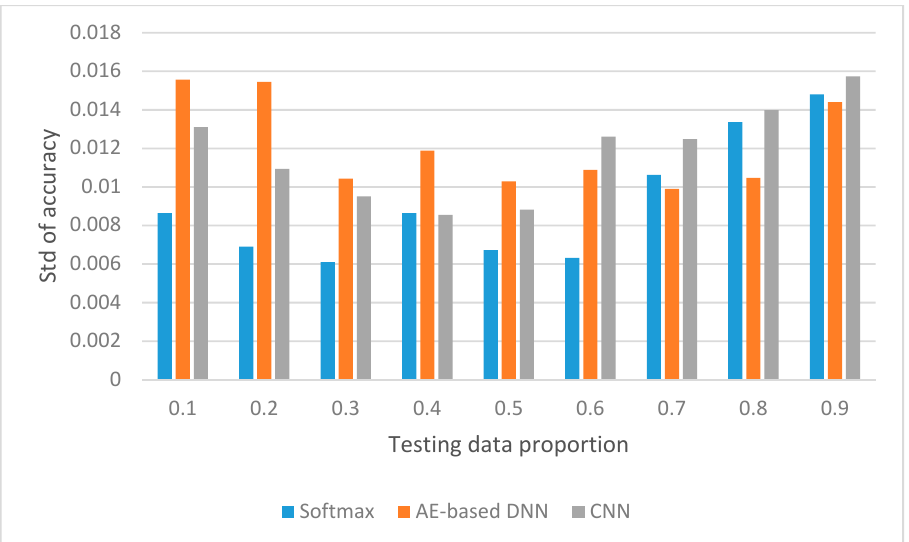
Figure 11. Comparison of the standard deviation of classification accuracy for the three methods